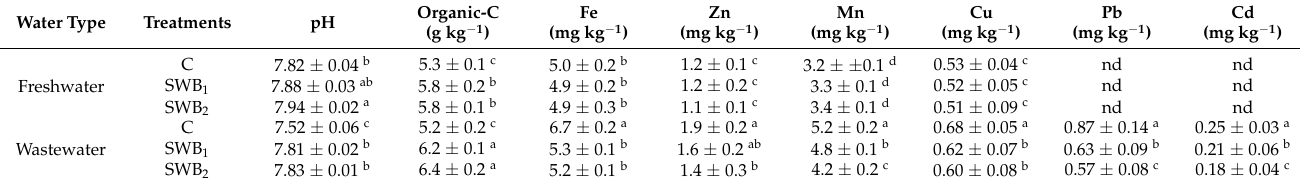
Table 4. Effect of shrimp-waste-derived biochar (SWB) rates on some soil characteristics and avail- ability of heavy metals after harvesting quinoa plants. C, SWB 1 , and SWB 2 are 0, 1, and 2% ( w / w ) of biochar. Means ( ± SD, n = 5) with different letters indicate significant differences. nd = not detected. The detection limits for Cd and Pb are: 0.07 and 1.06 µ g L − 1 ,